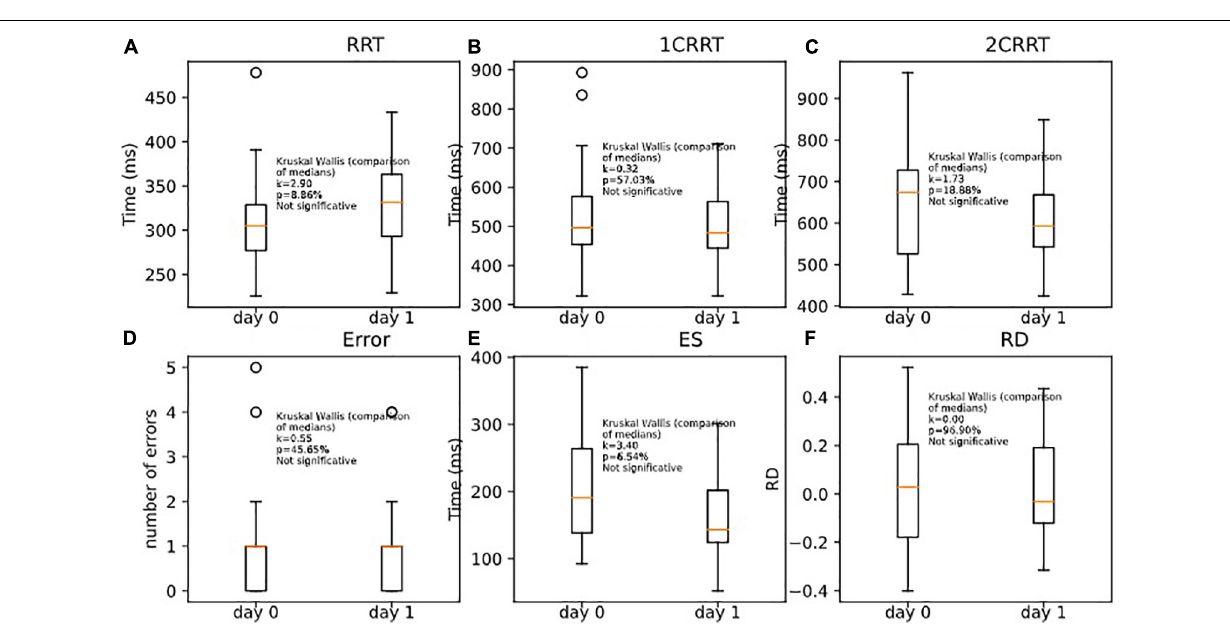
Frontiers in Neuroscience |